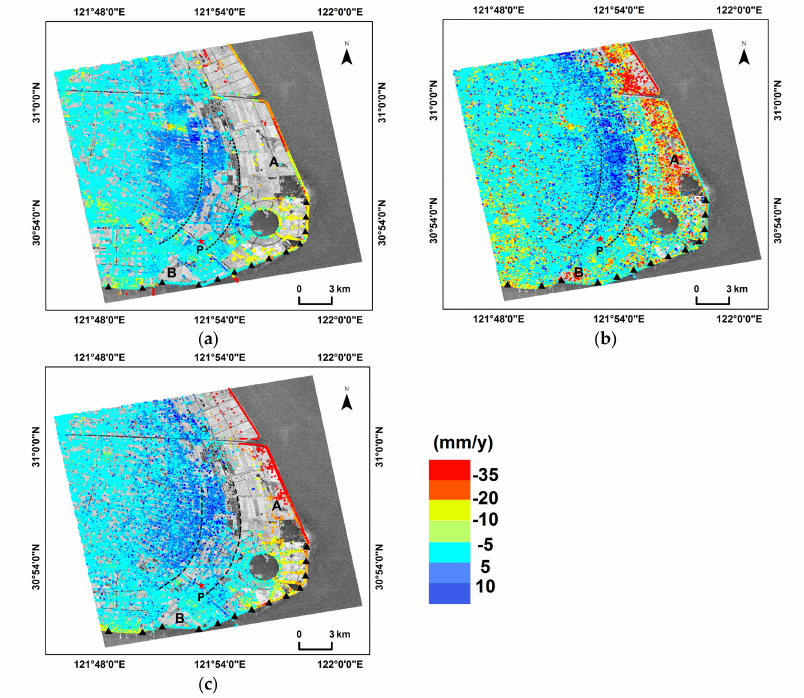
Figure 5. Motion rates of LNC derived by time series analyses using: ( a ) X-band TerraSAR-X; ( b ) L-band ALOS PALSAR; ( c ) C-band ENVISAT ASAR data stacks. Red Star indicates the reference point. Black triangles indicate the locations of leveling benchmarks. The background is a mean amplitude map of 11 TerraSAR-X